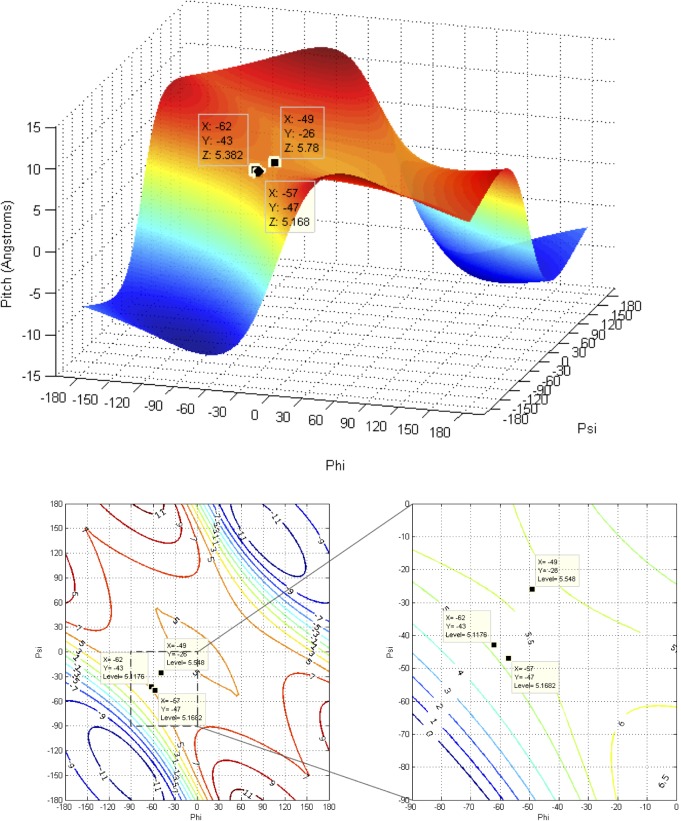
Contours and 3D surface showing number of residues-per-turn (n) overlaid on 2D φ, ψ plot.Positions of classic α-helix (φ = −57, ψ = −47), 310-helix (φ = −49, ψ = −26), and experimental Némethy-, N- or 3.613/10-helix (φ = −62, ψ = −43) are indicated. Note that n is approximately the same for the α- and 3.613/10-helices.